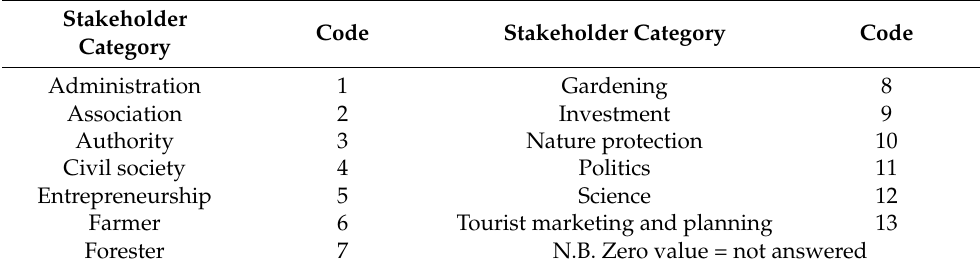
Table 4. Codes of stakeholder groups used for the scatter chart in Figure